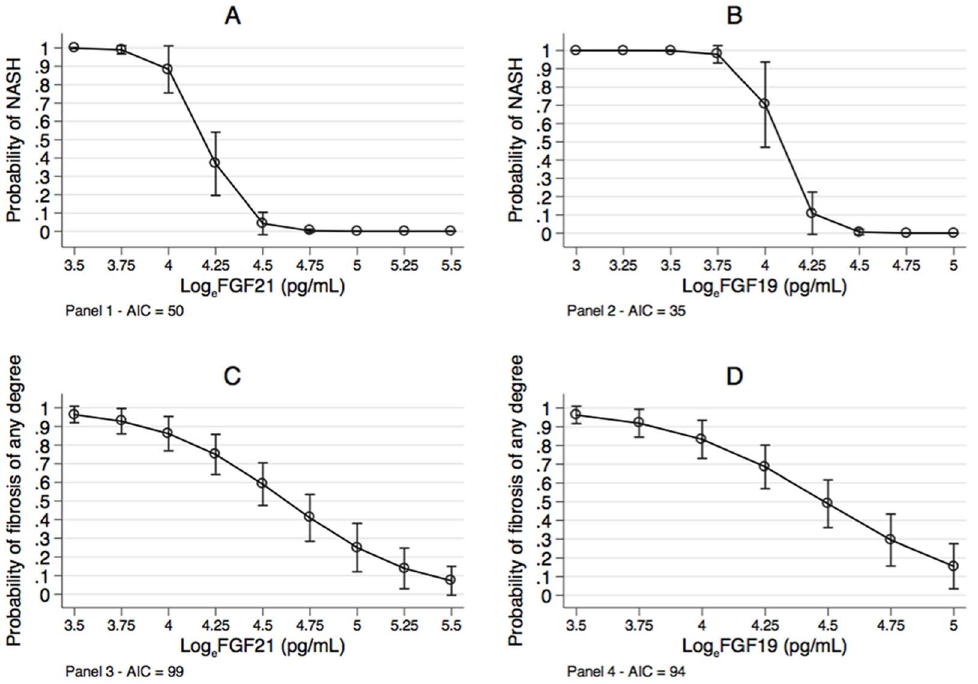
Figure 2. Probability of NASH and fibrosis as a function of serum FGF21 and FGF19. Probability of NASH and fibrosis of any degree as a function of log e -transformed values of FGF21 and FGF19 (see text for further details on statistical analysis). Abbreviations: NASH=non-alcoholic steatohepatitis; log e =natural logarithm; AIC=Akaike information criterion. Circles are means and bars 95% confidence intervals.